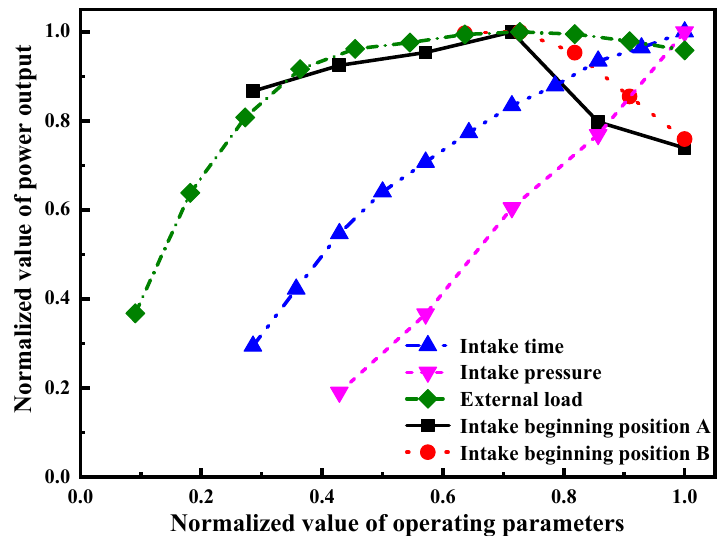
Figure 18. Influence of operating parameters on power output.